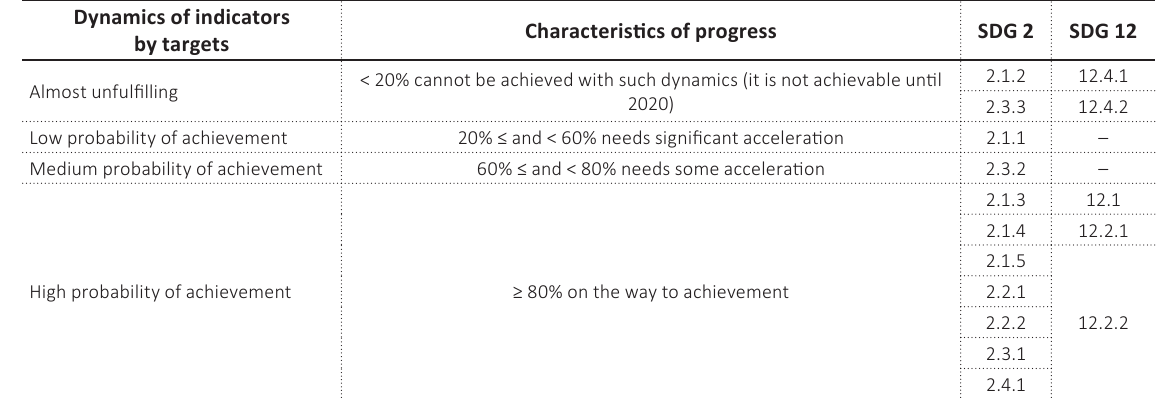
Table 2. Assessment of progress in achieving the targets of SDGs 2 and 12 in Ukraine based on national monitoring